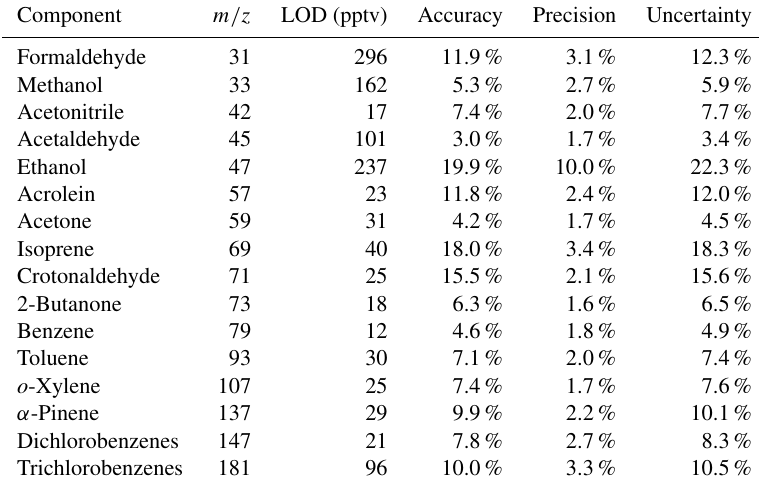
Table 1. Detection limit, accuracy, precision, and total uncertainty of the PTR-MS for individual VOCs in gas standard.